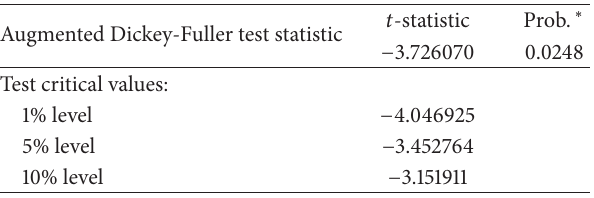
Table 1: Augmented Dickey-Fuller unit root test on